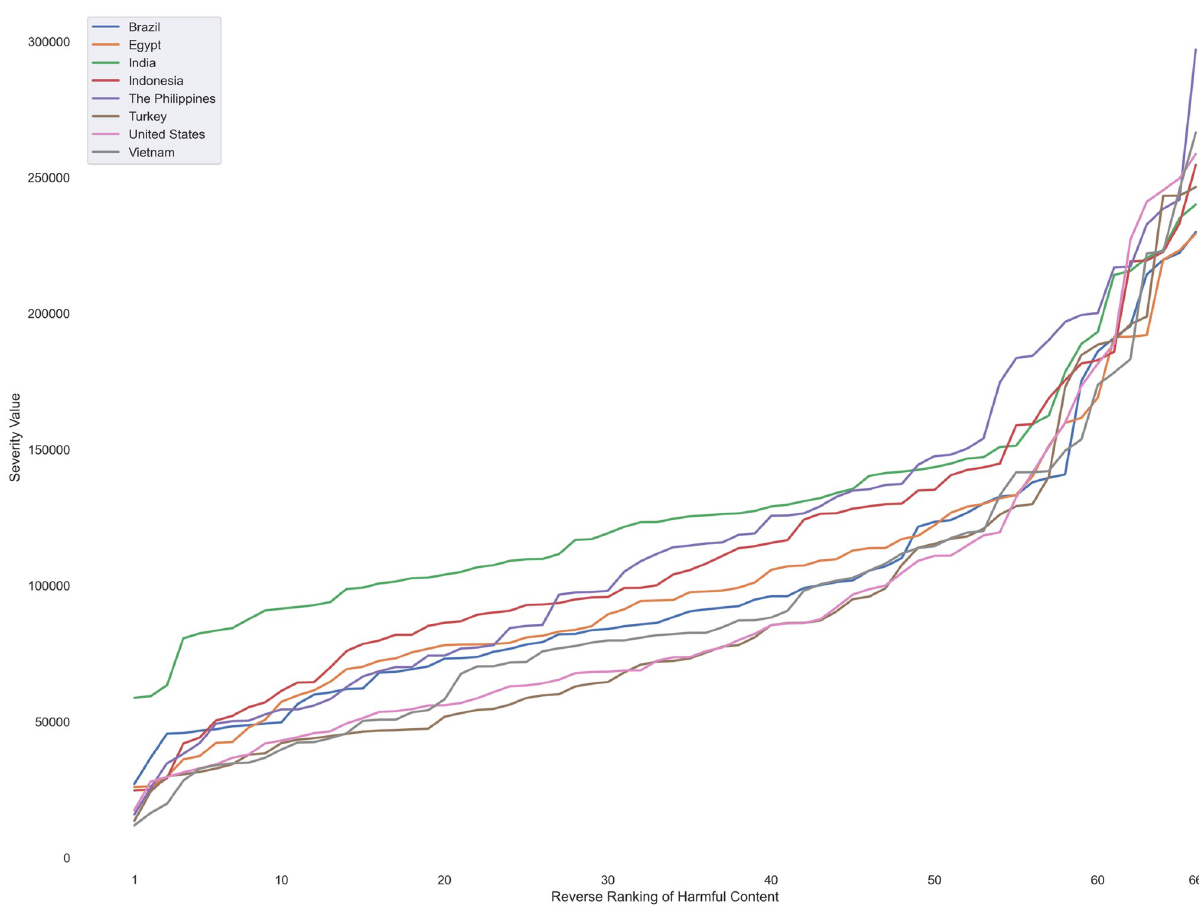
Fig 1. Plot of severity value vs. reverse severity rank order for each country under a free-text numeric measurement. Note that the same rank position may indicate different harmful content for different countries.